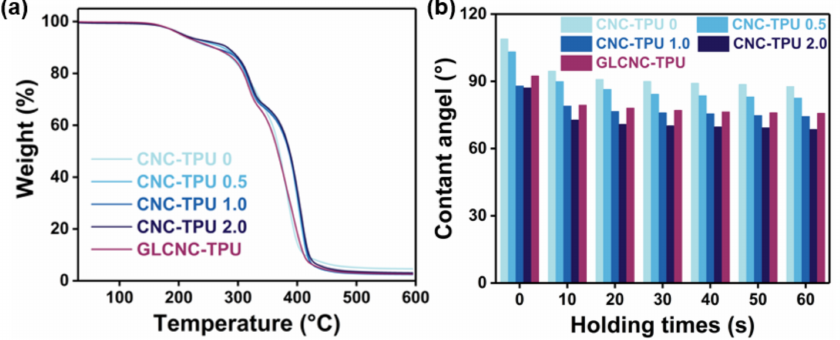
Figure 8. ( a ) TG curves and ( b ) water contact angle of CNC/TPU and GLCNC-TPU composite